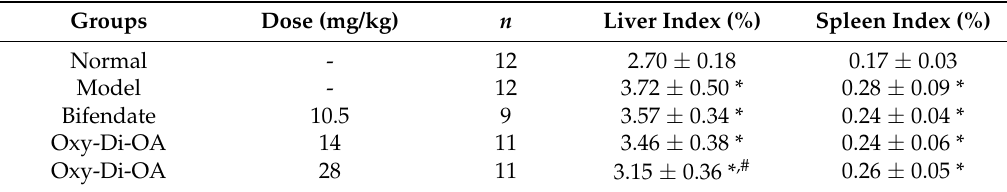
Table 2. Liver index and spleen indices in different experimental groups. Groups Normal